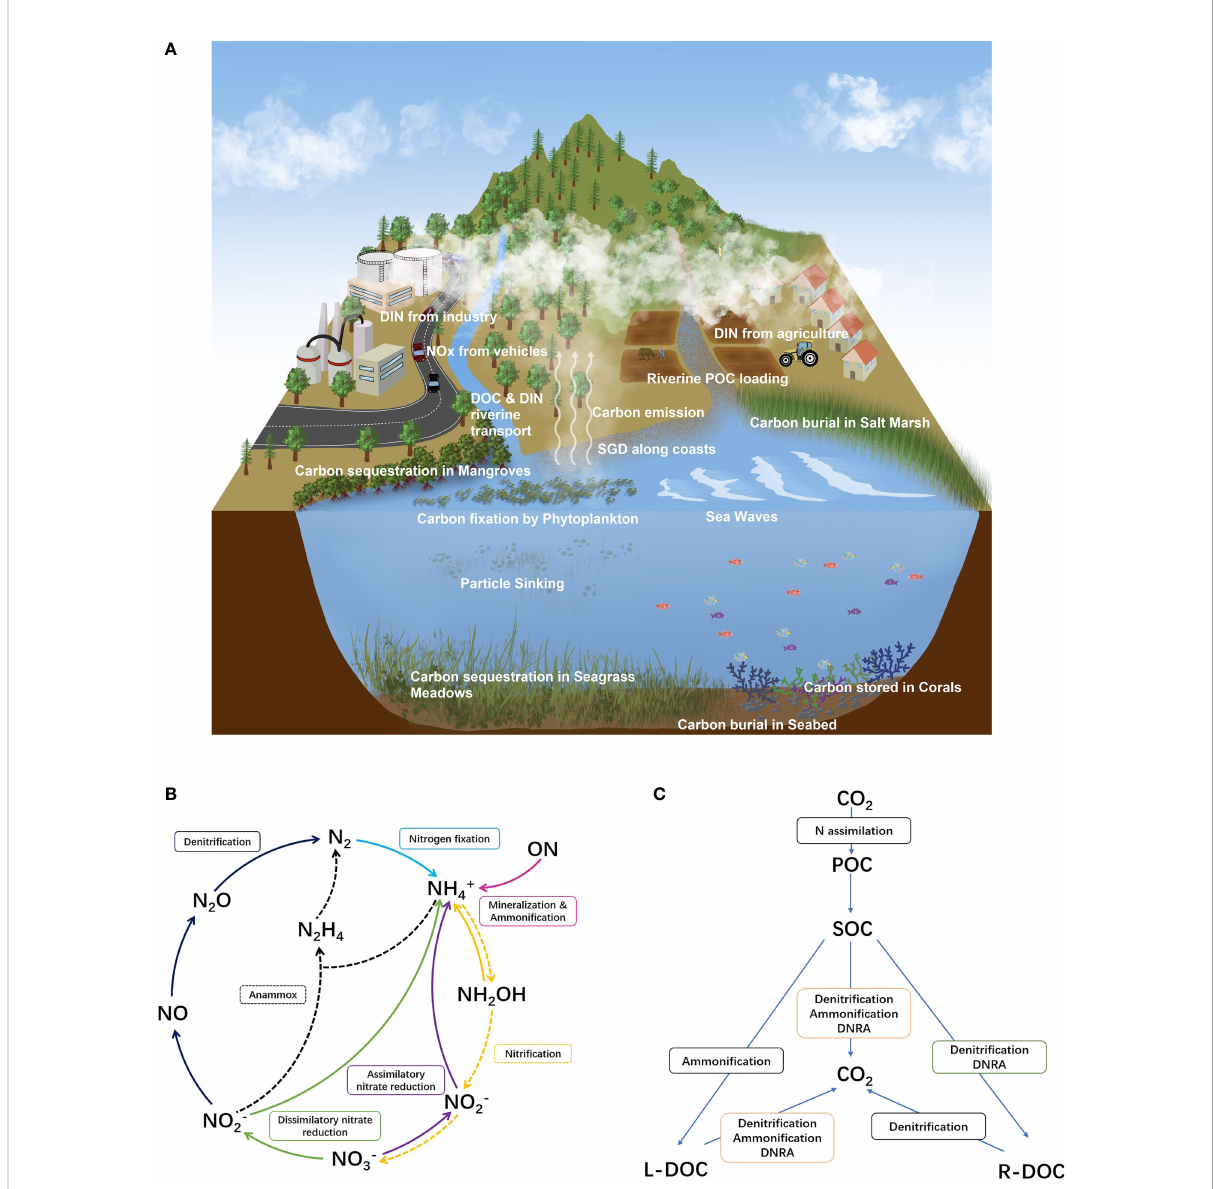
FIGURE 1 Sketch of carbon storage and transport routes in coastal zones (A) . This fi gure also shows the main transport routes of terrestrial DIN to the coast; (B) Biogeochemical cycling of N in marine environments with different pathways. ON indicates organic nitrogen. In the fi gure, reactions with dash lines indicate autotrophic reactions while the solid indicates heterotrophic reactions; (C) transformation among SOC, labile DOC (L-DOC), recalcitrant DOC (R-DOC), POC and CO 2 in sediment environments coupled with different N reaction pathways (including priming